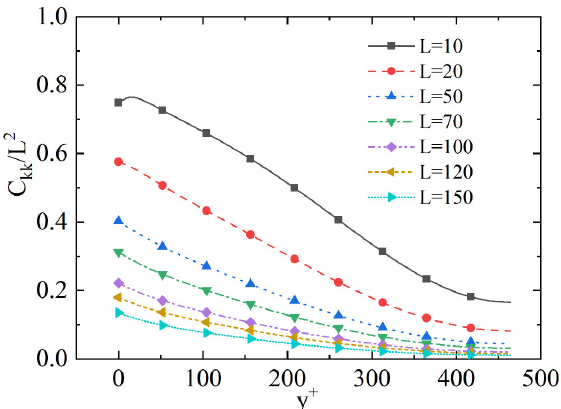
Figure 13. Dimensionless component of the conformation tensor ( C kk / L 2 ) of different maximum extensibility of the polymer molecule ( L ).